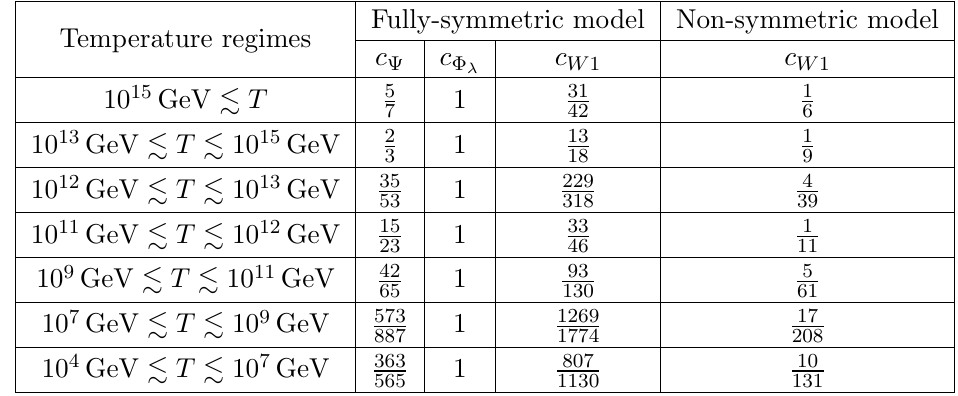
and c W 1 = 1 in di(cid:11)erent temperature regimes in c (cid:9) + 1 c (cid:8) 3 2 (cid:21) (cid:21) c (cid:9) in the non-symmetric model. For 3